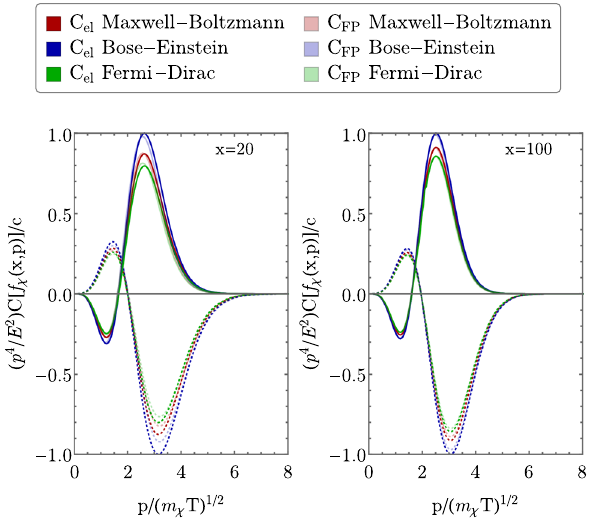
Fig. 11 Same as in Fig. 9, but for the case of ultra-relativistic bath particles with r = 0 (and constant scattering amplitude)